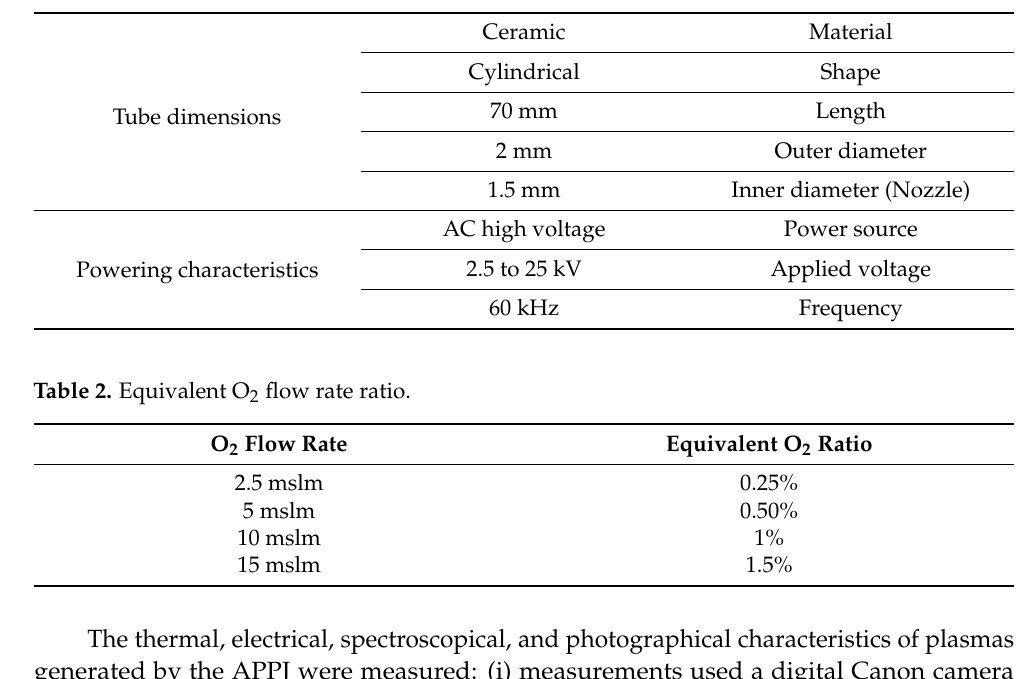
Figure 1. ( a ) Schematic diagram of APPJ experimental set-up; ( b ) Typical example of a ground electrode; ( c ) Plasma jet width and length as calibration scale. Table 1. Tube dimensions and powering characteristics.